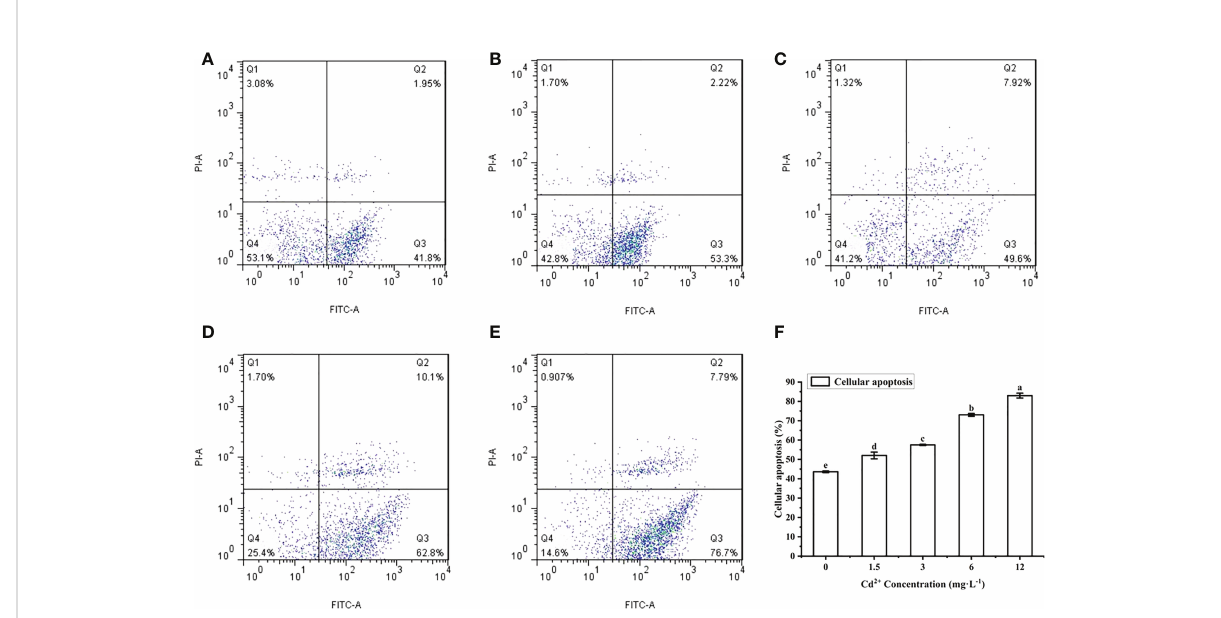
FIGURE 4 Detection of apoptosis in M. meretrix ovarian cells by fl ow cytometry. (A) control group; (B) 1.5 mg L − 1 ; (C) 3 mg L − 1 ; (D) 6.0 mg L − 1 ; and (E) 12 mg L − 1 Cd 2+ concentration. (F) The plot shows the rate of apoptosis in M. meretrix ovarian cells as determined from the fl ow cytometry data. Signi fi cant ( P < 0.05) differences among groups are indicated by different letters above the bars in the